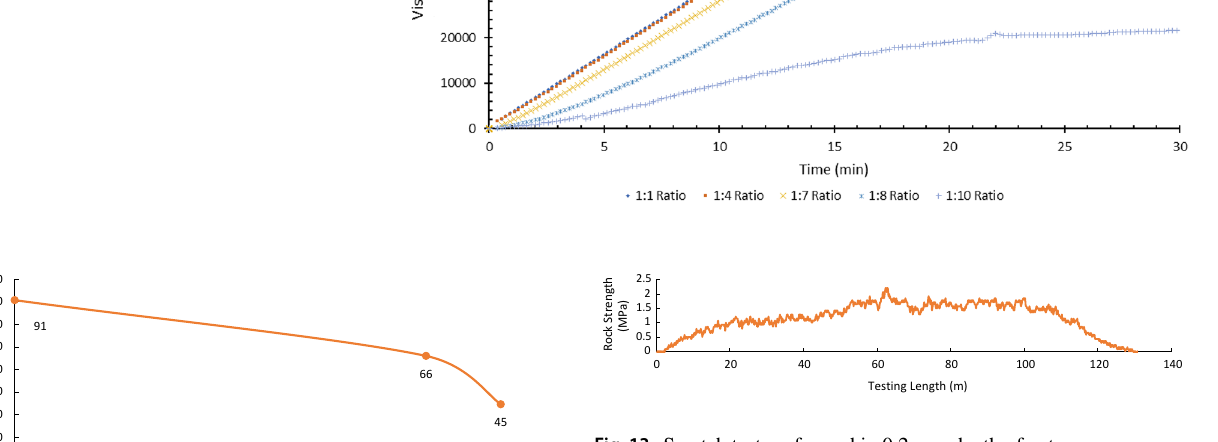
Fig. 13 Scratch test performed in 0.2 mm depth of